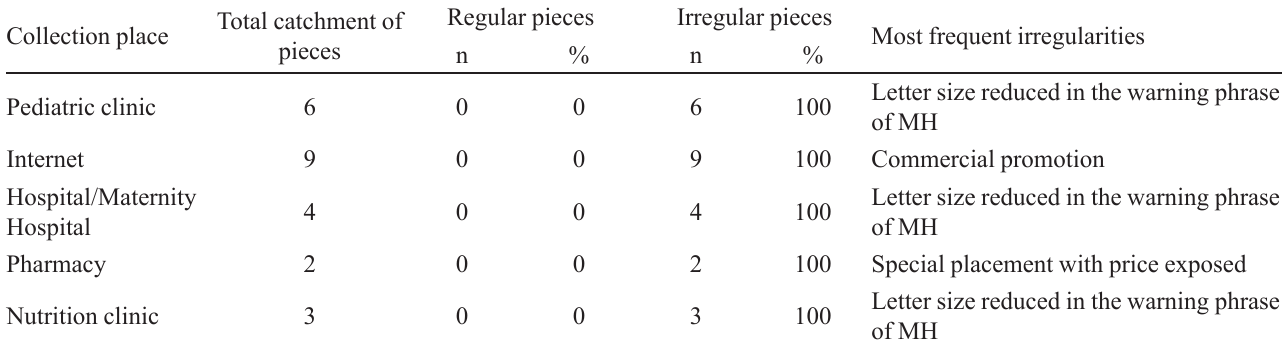
TABLE II - Analysis respecting advertisement of infant formulas for nursling and follow-up infant formulas for nursling (A), concerning legislation, according to collection place Collection